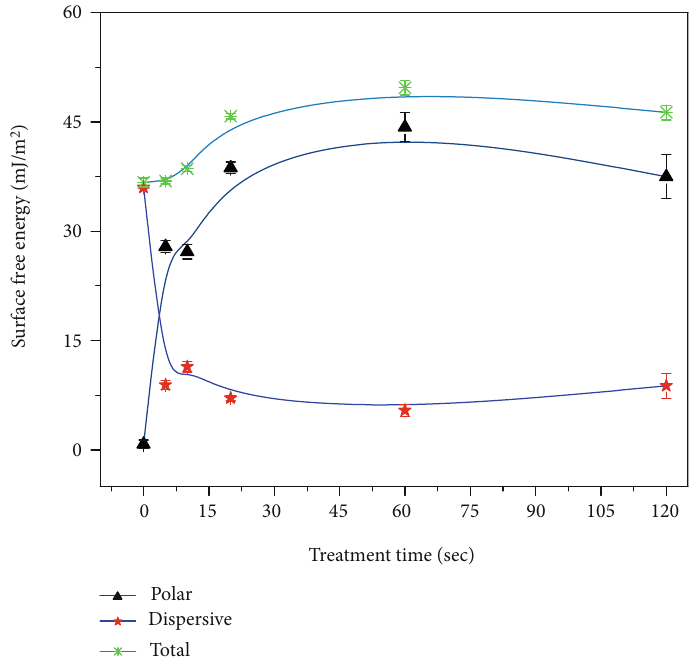
Figure 6: Variation of surface free energy of polypropylene with treatment